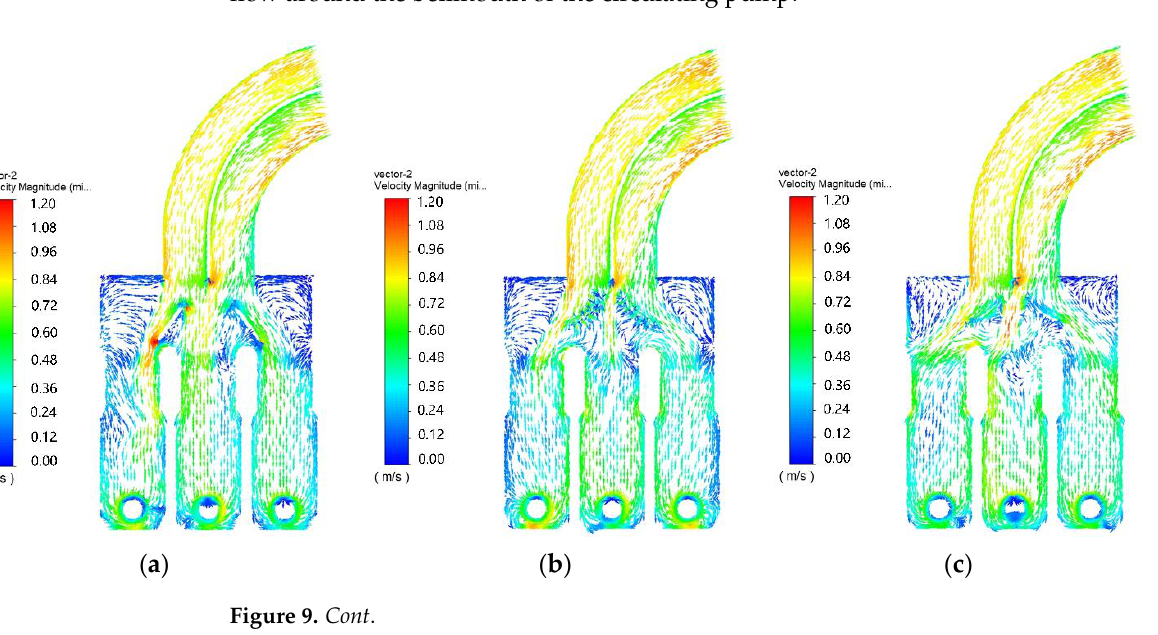
Figure 8. Plan 1 isogram of velocity. ( a ) Center section of pump body along flow direction. ( b ) Center section of pump body in vertical flow direction.